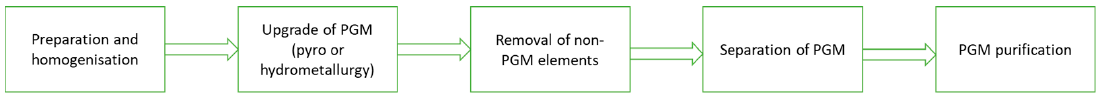
Figure 4. Main steps to recover PGM from used catalytic converters. Adapted from [40].